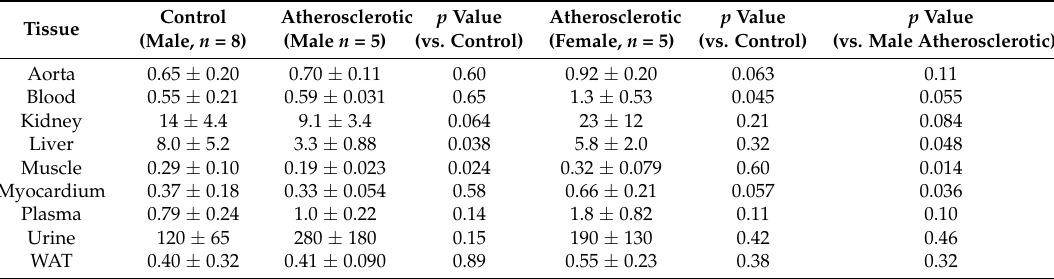
p Value (vs. Control)